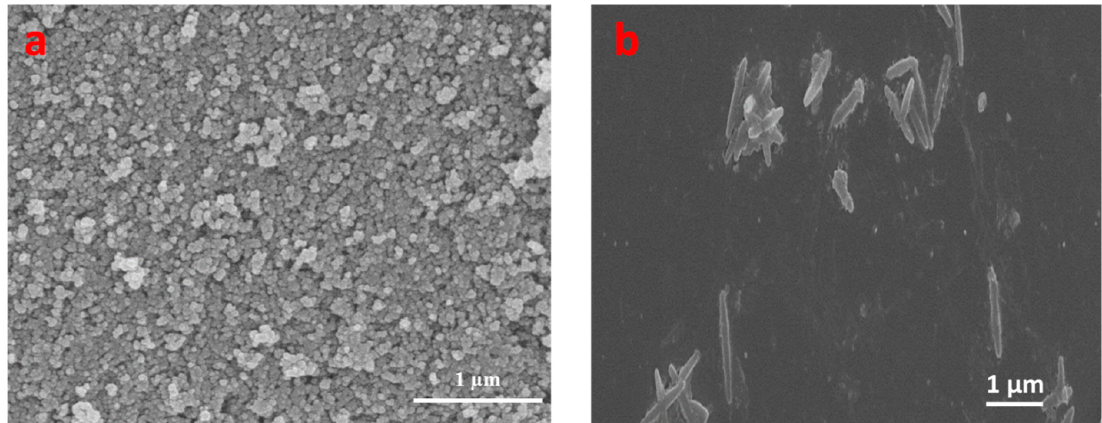
Figure 2. FESEM images of ( a ) P25 and ( b ) T-{001}.